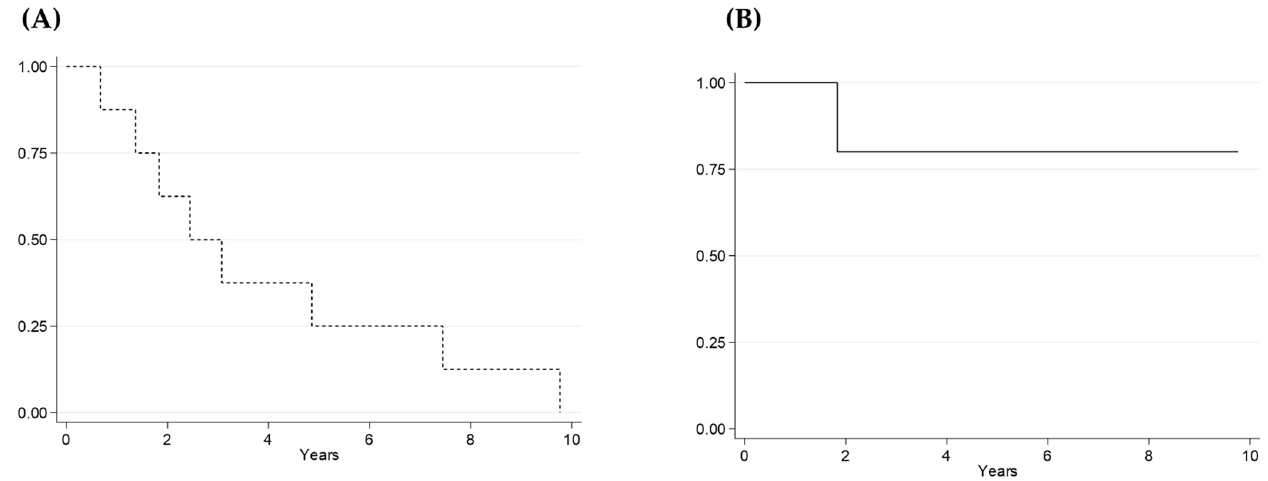
Figure 4. Disease-free survival in 9 patients treated with somatostatin analogues, according to the period of the therapy: without treatment ( A ), and with somatostatin analogues ( B ).